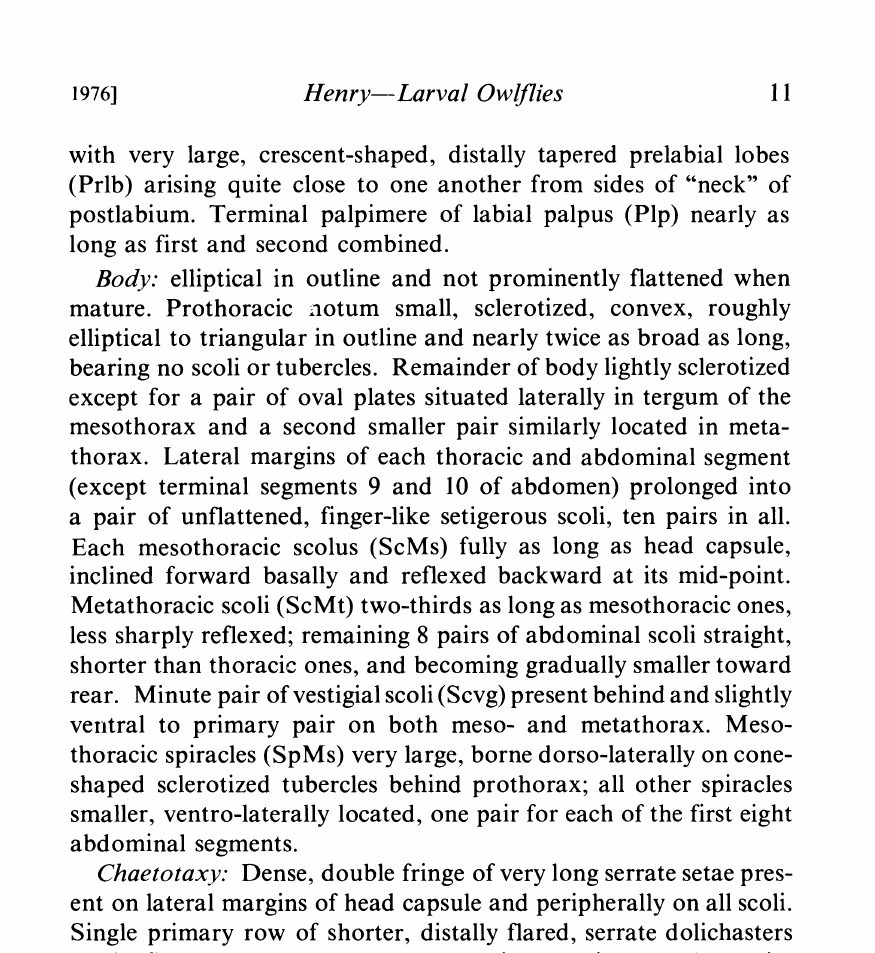
Figure 3. [opposite page] Ululodes mexicana, details of head capsule of mature third instar. A anterior dorsal aspect, B anterior ventral aspect. AT antennal tubercle, Cd maxillary cardo, ER epistomal ridge, excv lateral excavation, Gu gular area, Gul gular line, LmM labral margin, MdCV ventral mandibular condyle, OT ocular tubercle, Plb postlabium, Prlb prelabial lobe, Plp= labial palp, SgR subgenal ridge, SSt stellate-tipped seta, St maxillary stipes, TAP anterior tentorial pit, TPP posterior tentorial